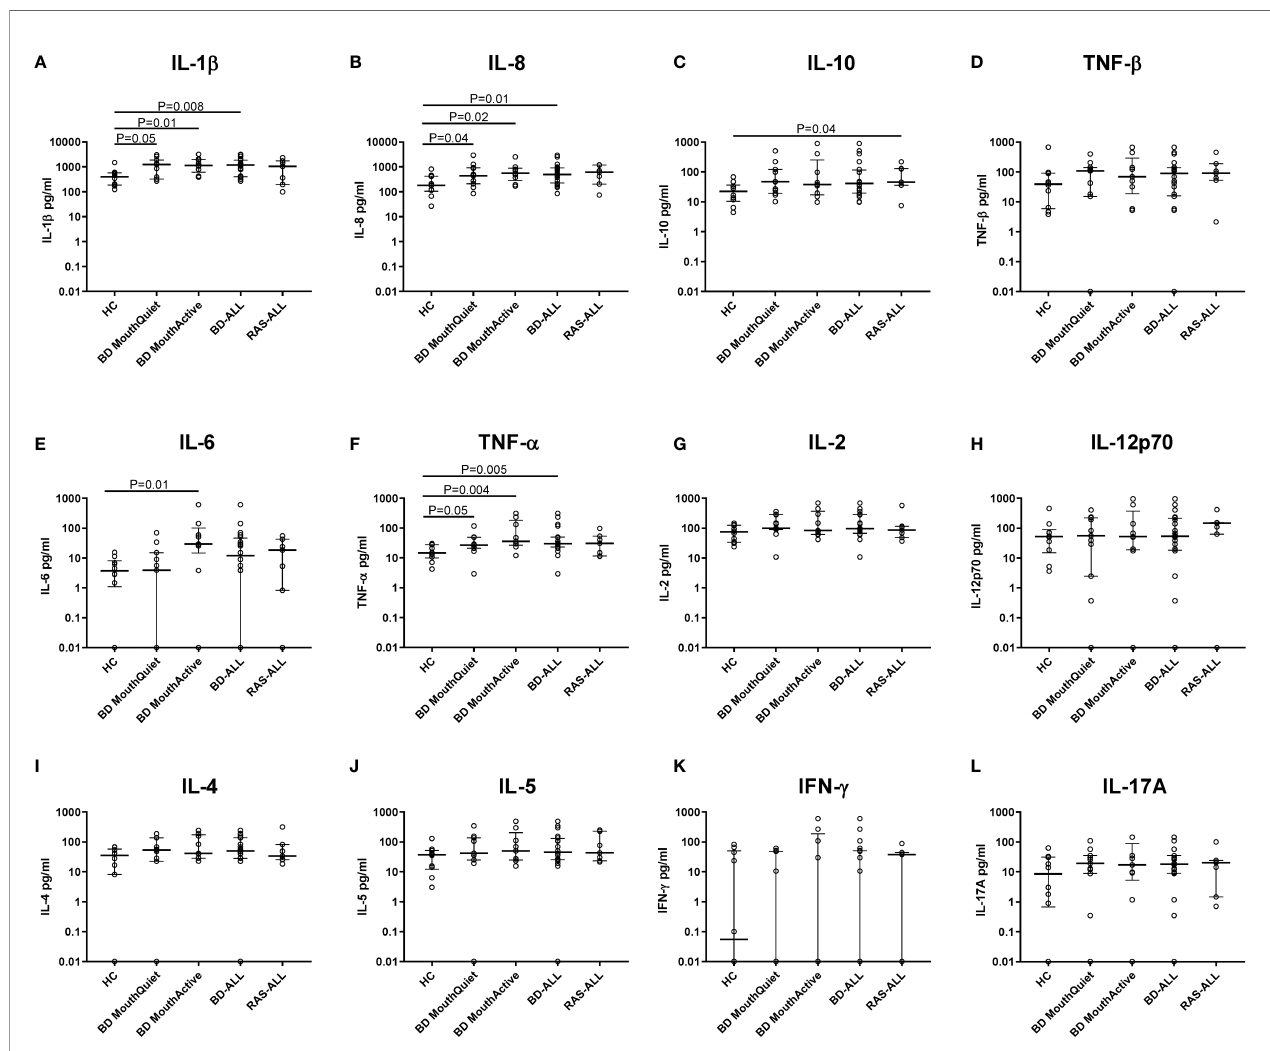
FIGURE 4 | Saliva cytokine levels normalised to total protein differentially expressed in BD and RAS patients as compared to HCs. Plots show the cytokine concentrations (pg/ml) from BD-ALL (N=20), RAS-ALL (N=7) and HC (N=10). The BD patients were further grouped into patients with oral ulceration, BD Mouth Active (N=9), and patients with no oral ulceration, BD Mouth Quiet (N=11). (A) IL-1 b , (B) IL-8, (C) IL-10, (D) TNF- b , (E) IL-6, (F) TNF- a , (G) IL-2, (H) IL-12p70, (I) IL-4, (J) IL-5, (K) IFN- g , (L) IL-17A. The median and interquartile range are shown (Median ± IQR). Mann-Whitney U test, signi fi cance based on two tailed 95% con fi dence interval (CI). Exact P values are